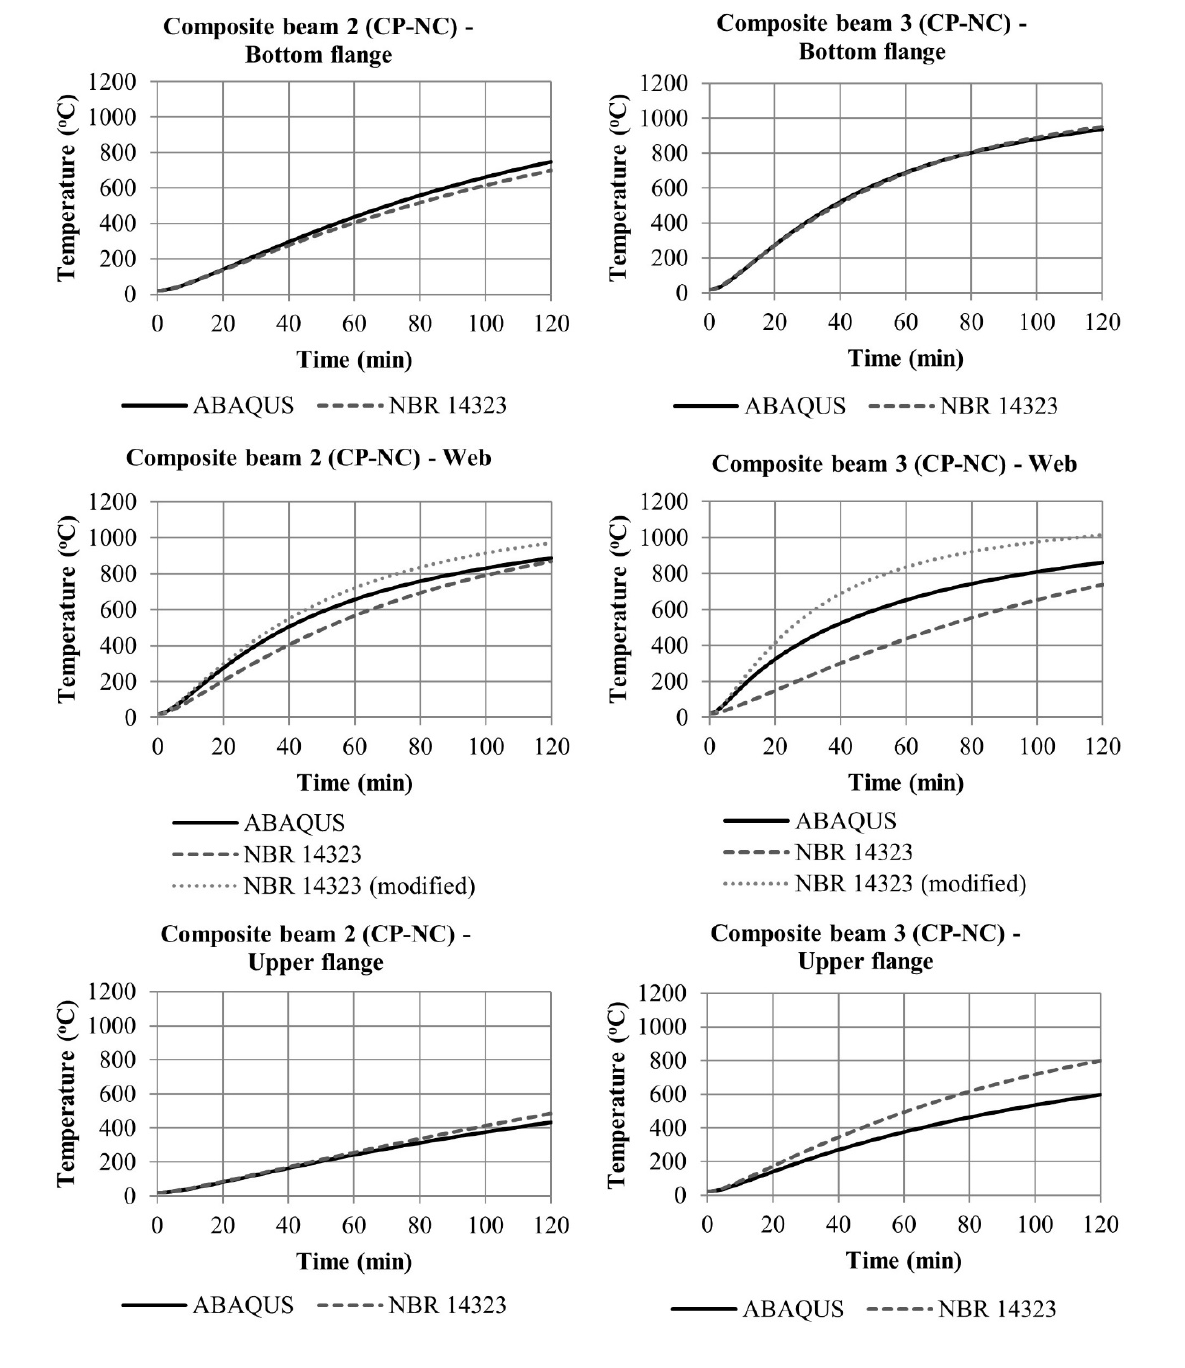
Figure 11. “Temperature x time” curves obtained by the simplified method and by the advanced calculation method for the profiles of composite beams 2 (CP-NC) and 3